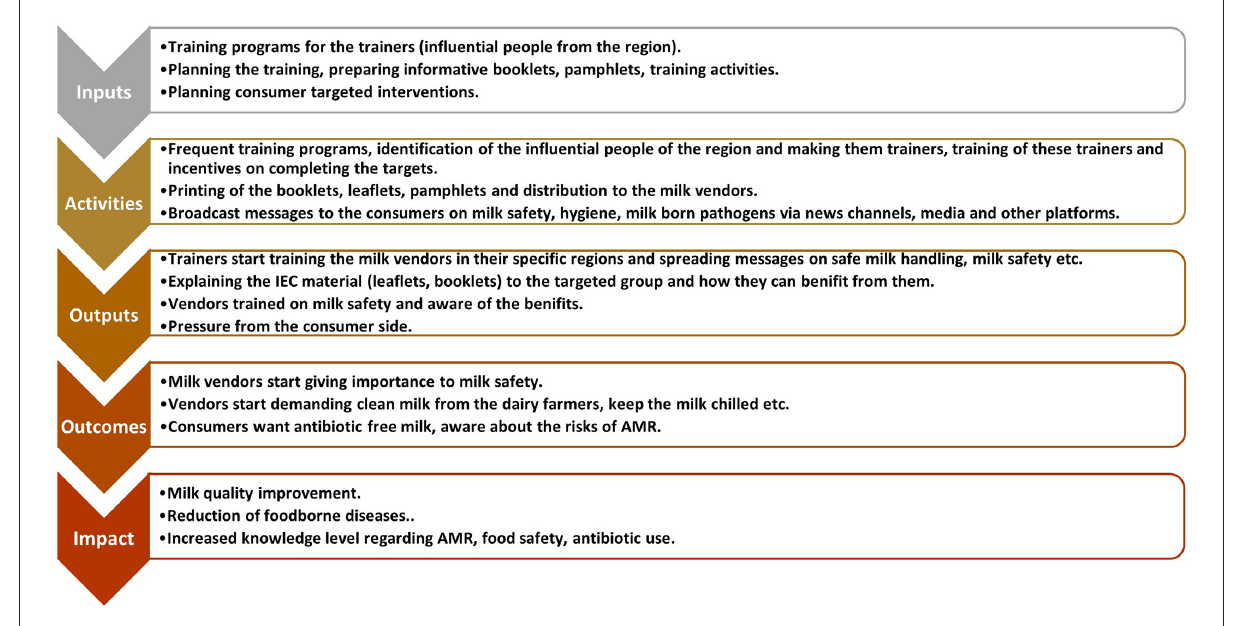
FIGURE5 A hypothetical theory of change targeting different actors along the dairy value chain to improve milk safety.